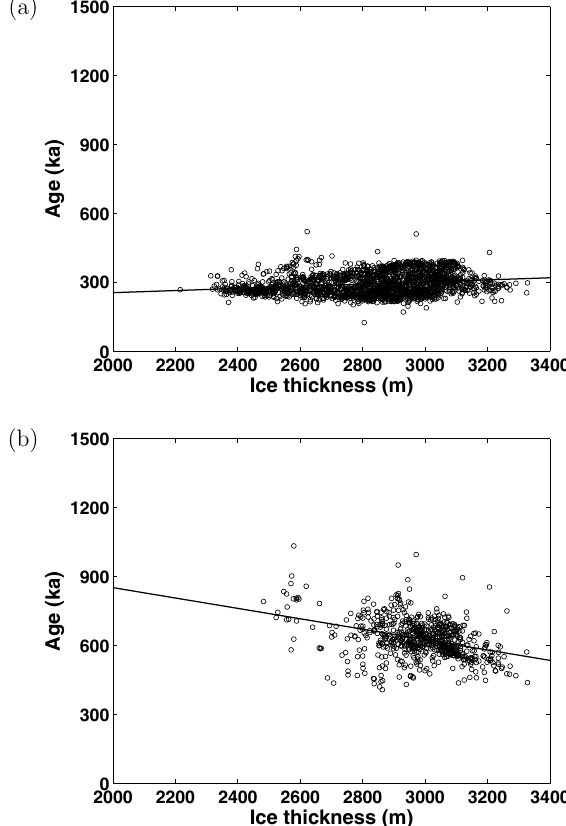
Figure 1: Anisotropic steady-state run: (a) Age at 95% depth vs. ice thickness for all Fig. 14. Anisotropic steady-state run: (a) age at 95% depth vs. ice nodes of the finite-element mesh; linear regression line. (b) Basal age vs. ice thickness for thickness for all nodes of the finite element mesh; linear regression all nodes of the finite-element mesh where the basal temperature is at the pressure melting line. (b) Basal age vs. ice thickness for all nodes of the finite ele- point; linear regression line. ment mesh where the basal temperature is at the pressure melting point; linear regression